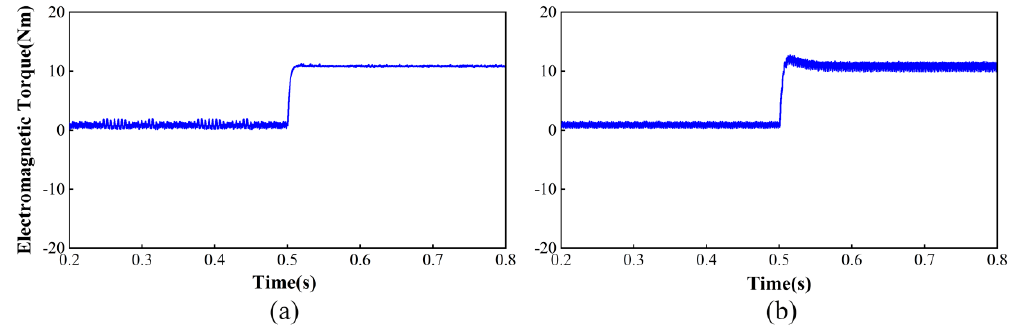
Figure 4. Electromagnetic torque of the ( a ) NOD–SMC controller and ( b ) I–SMC controller.